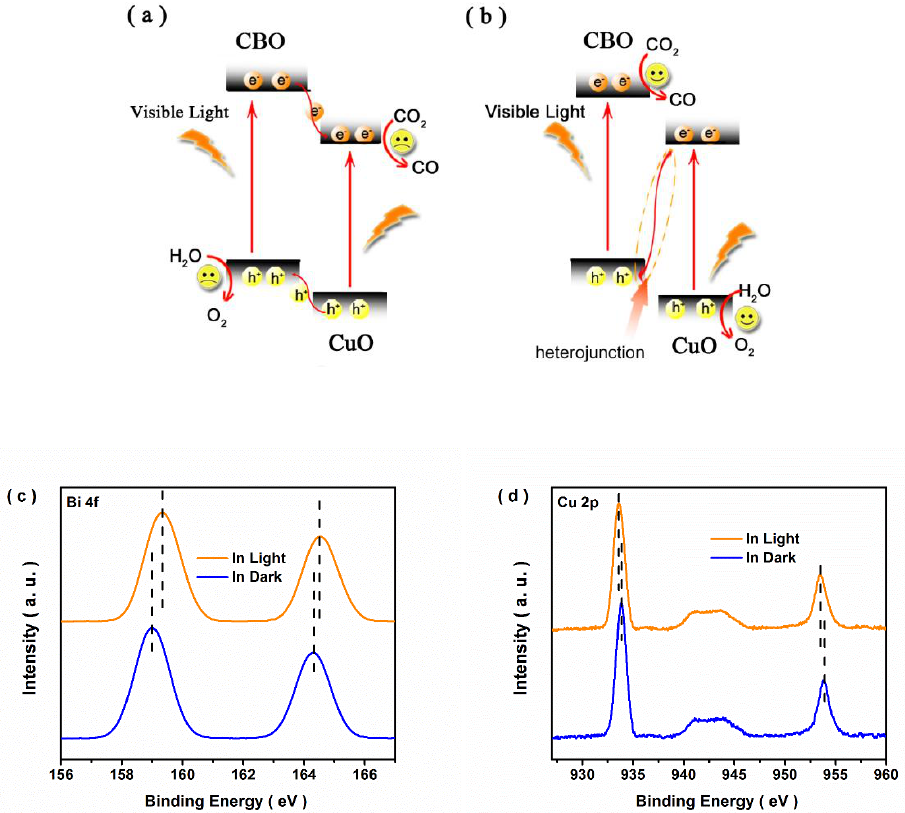
Figure 7. Schematic diagrams of the ( a ) common double-charge transfer and ( b ) S-scheme charge transfer modes in the CBO/CuO heterojunction; In situ-XPS spectra of ( c ) Bi 4f and ( d ) Cu 2p for the 30CBO/CuO sample.